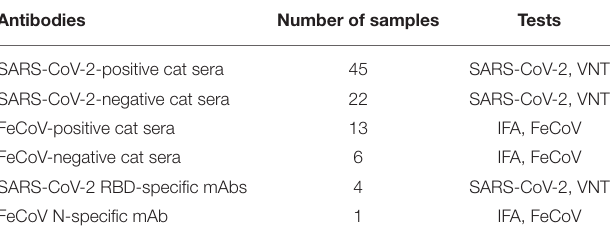
TABLE 2 | Cat sera and monoclonal antibodies used in the study. Antibodies Number of samples